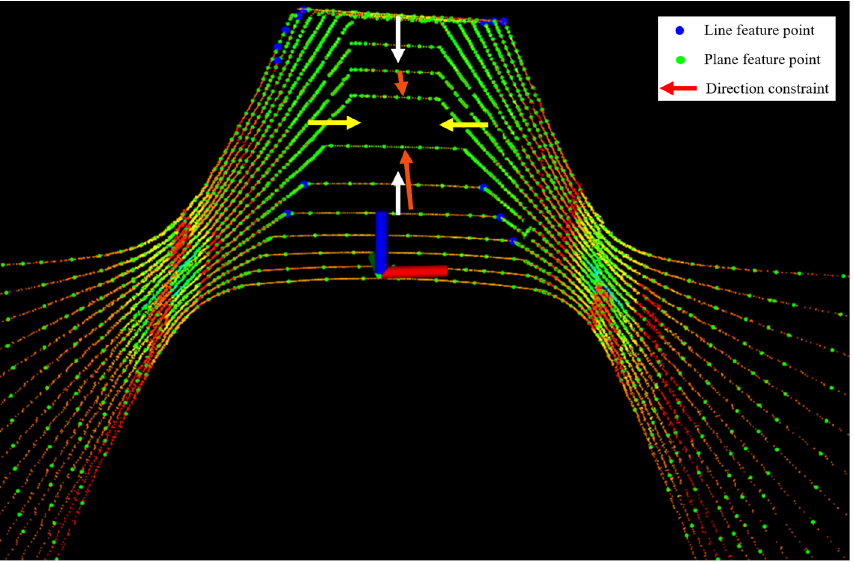
Figure 3. The extraction results of line and plane feature points in the preparation roadway. The red, white and yellow arrows are constraints in the three-axis direction.